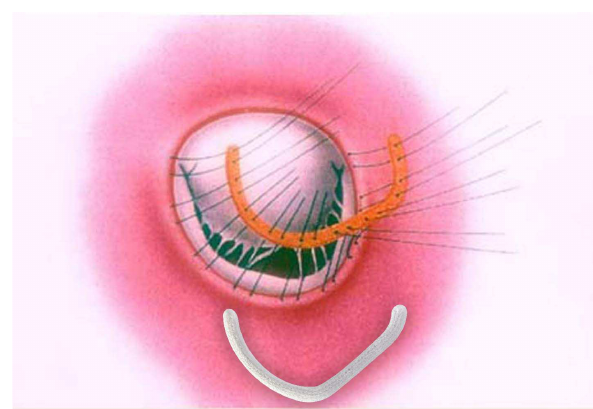
Fig. 12 – Schematic drawing showing the implantation of the Gregori-Braile ring prosthesis. Below the Gregori-Braile ring prosthesis